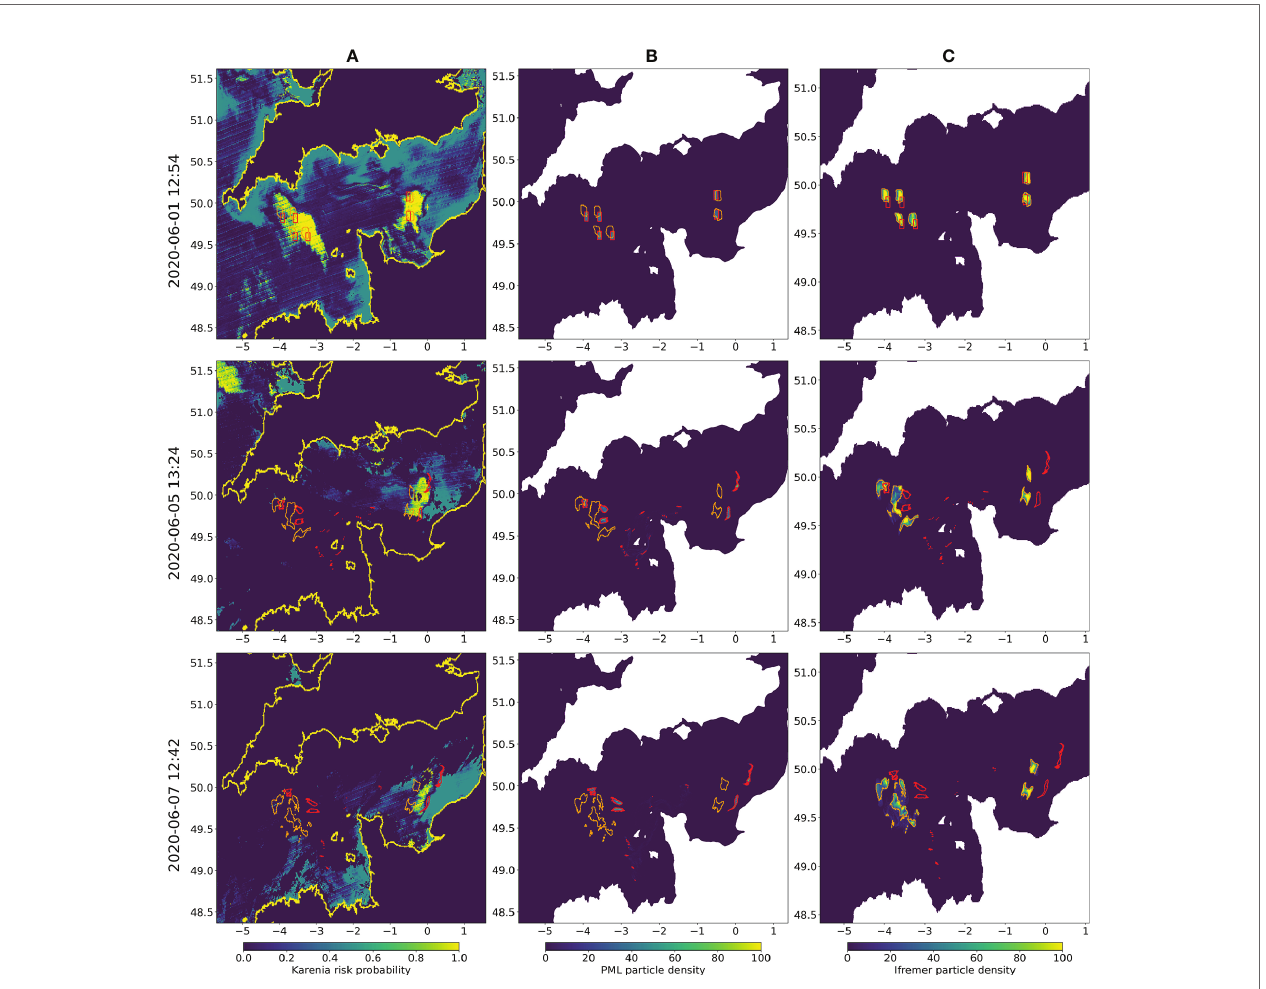
FIGURE 9 | Comparison of HAB risk from remote sensing (A) and particle densities for PML model (B) and IFREMER (C) , on selected days with clearer satellite image of Karenia risk (2020/06/01 12:54, 2020/06/05, 2020/06/07). The polygons of high particle density for PML model (red) and IFREMER (orange) are shown in each